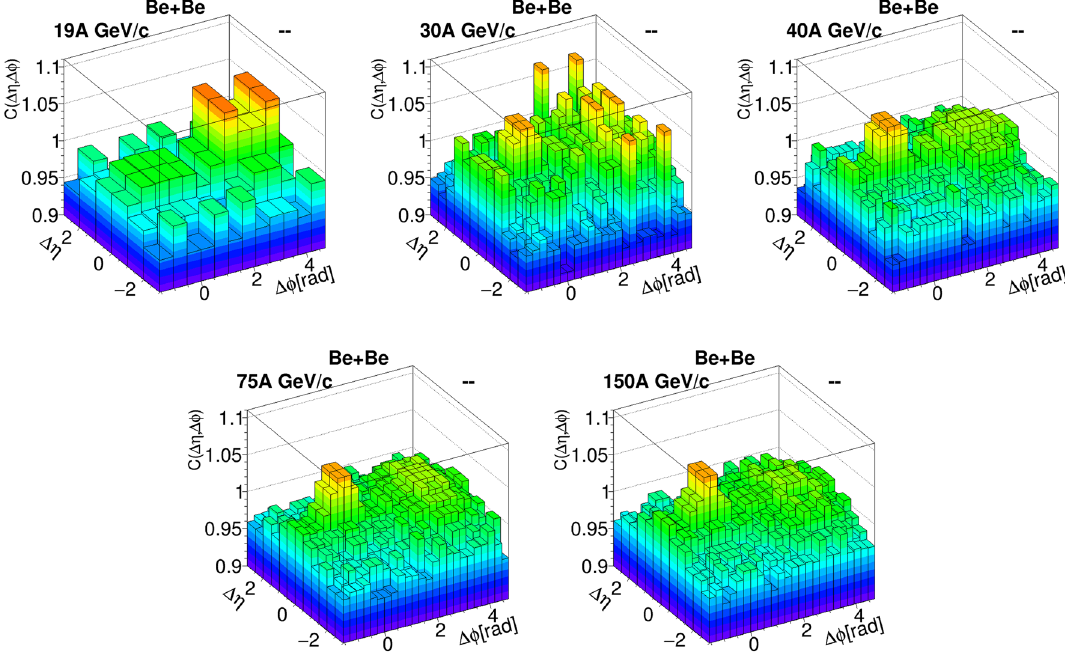
Fig. 9 Two-particle correlation function C ((cid:2)η,(cid:2)φ) for negative charge pairs in the 5% most central Be + Be collisions at 19 A –150 A GeV /